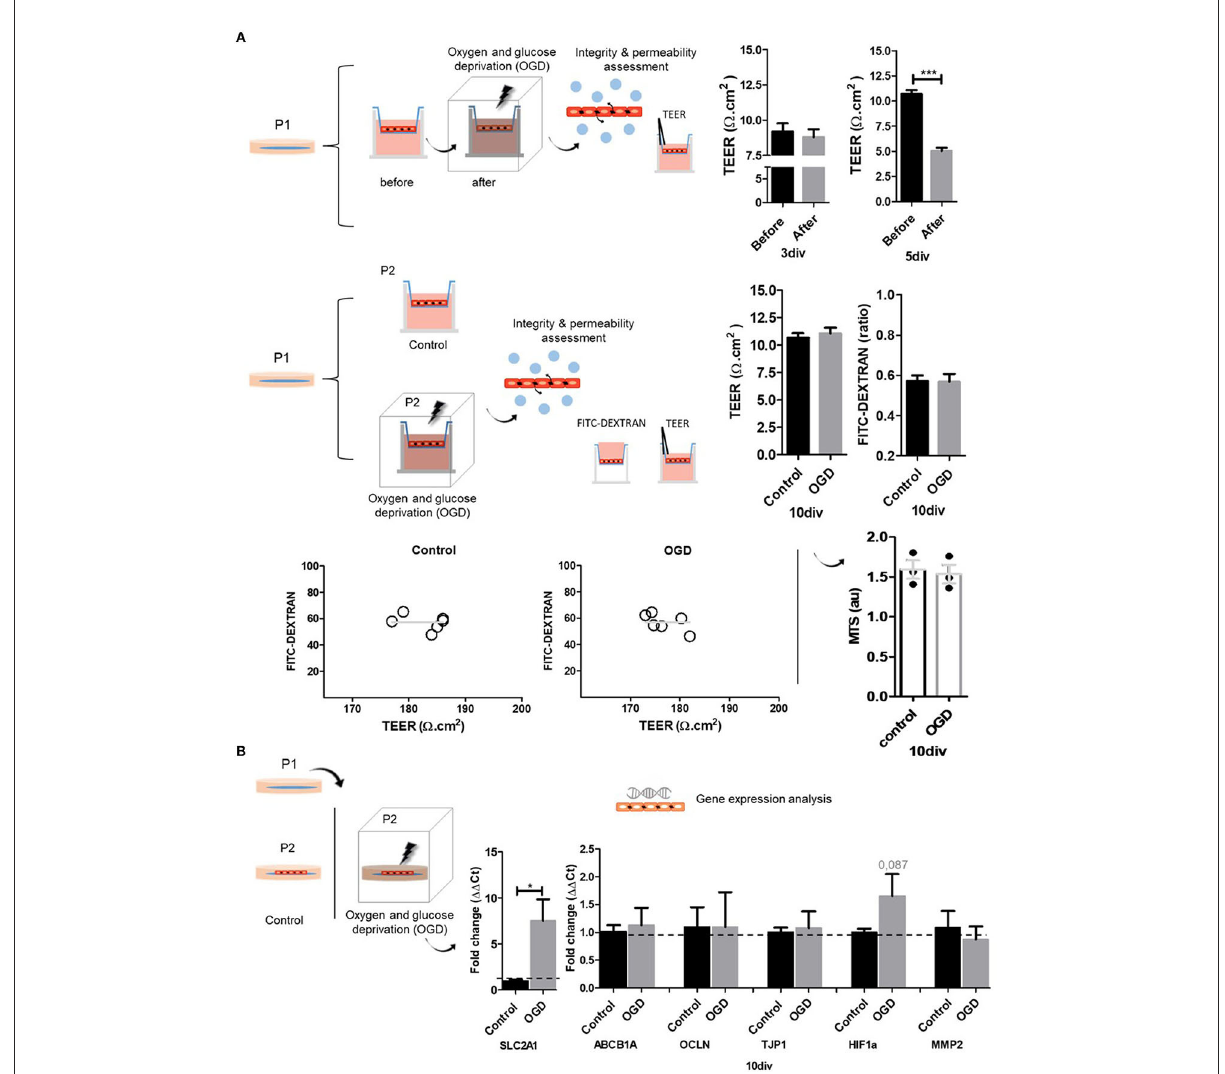
FIGURE4 Oxygen and glucose deprivation (OGD) model of hypoxia. (A) We use two OGD experimental designs. a before-after and a control-OGD samples. We measured TEER, diffusion/FITC-DEXTRAN, and MTS. In the case of the before-after approach, at 3 div, OGD-BMECs primary cultures in inserts showed a slight reduction in TEER results, with no significant differences. At 5 div, OGD-BMECs primary cultures in inserts showed significant differences in TEER results. Control-OGD experimental design does not show changes at 10 div. TEER and diffusion assay relationship showed that TEER values remained independent from the FITC-DEXTRAN results. Cell viability (MTS) analysis at 10 div does not show differences between control and OGD. (B) OGD experimental design (control and OGD) and gene expression analysis (qPCR). At 10 div, there was an increased expression of the SLC2A1 gene after OGD. ABCB1A, OCLN, TJP1, HIF1a, and MMP2 genes do not show significant changes. Nuclei are stained with DAPI (blue). N = 3. T-Test (* p ≤ 0.05, *** p ≤